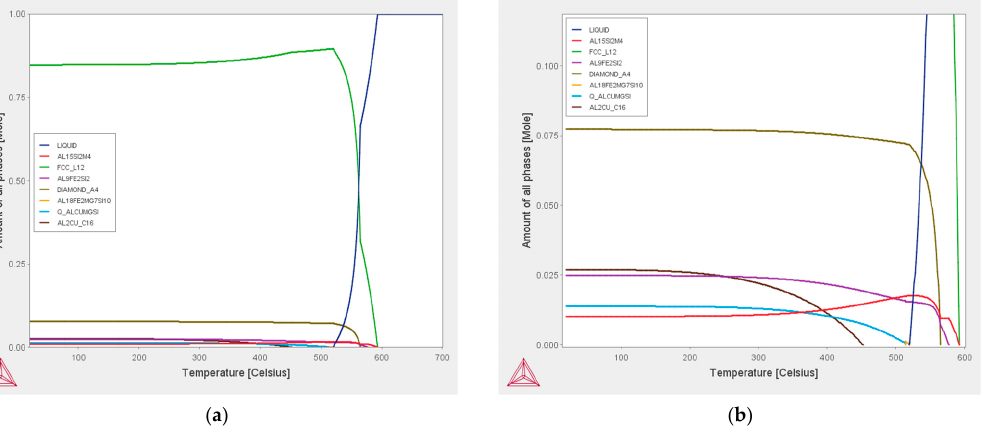
Figure 15. Thermo-Calc analysis of fraction of all phases formed in analysed alloy (equilibrium con- dition): full range ( a ) and magnification for range of intermetallic phases content ( b ).